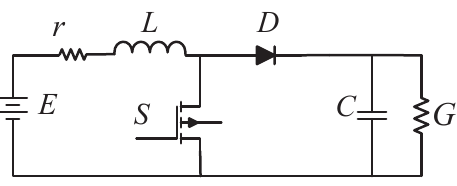
Figure 1. The circuit topology of DC–DC boost